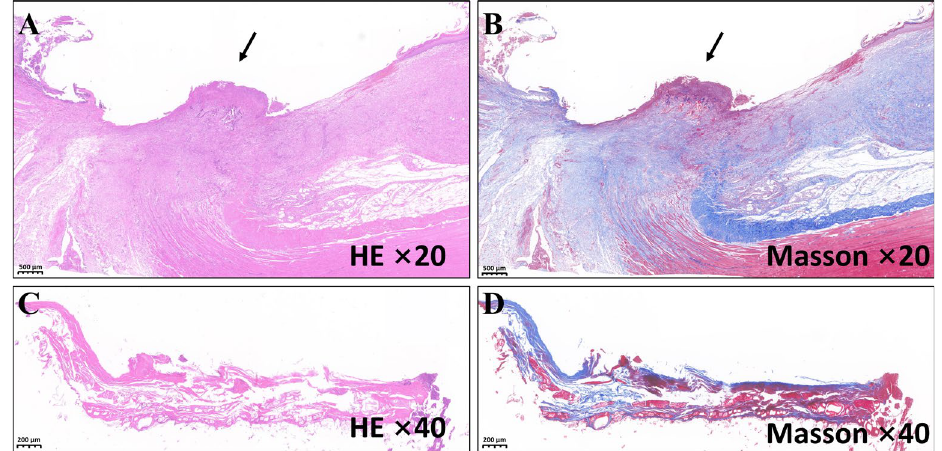
Figure 6. Histological specimens. ( A , B ) Anastomosis of bladder and abdominal wall. ( C , D ) Necrotic tissue between the parent and daughter